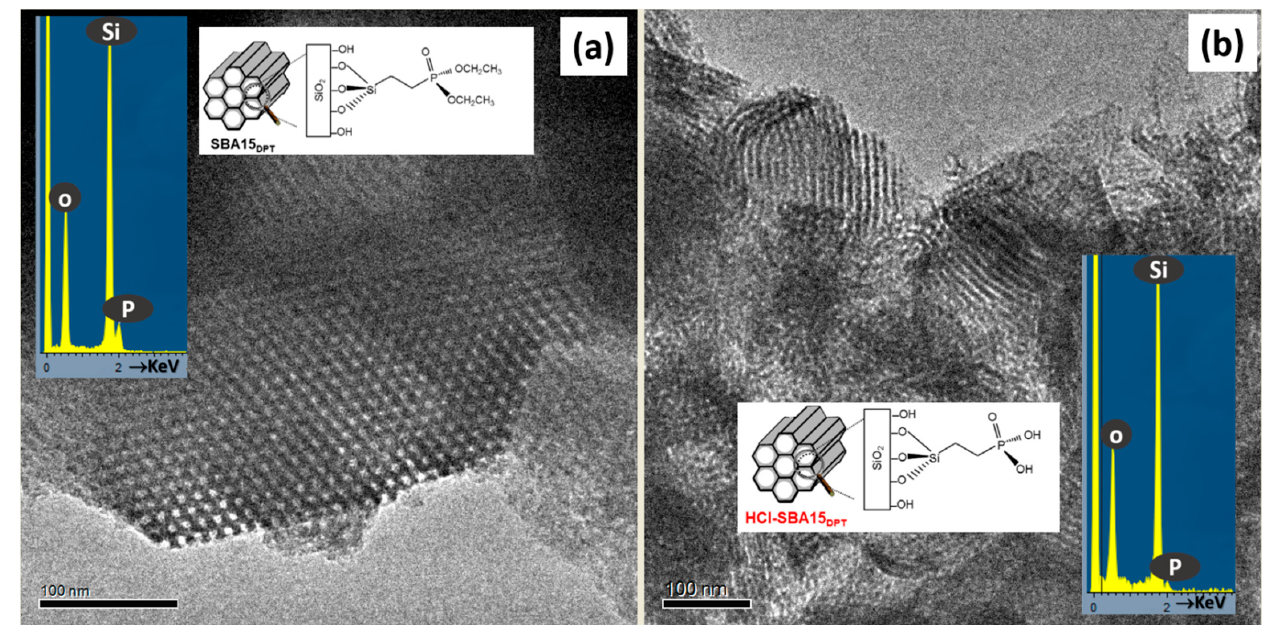
Figure 7. HRTEM images corresponding to ( a ) SBA15 DPT and ( b ) HCl-SBA15DPT. The images show a schematic representation of the functionalization and the typical EDS analysis. Adapted with permission from [83]. Copyright 2012 Royal Society of Chemistry (London, UK).